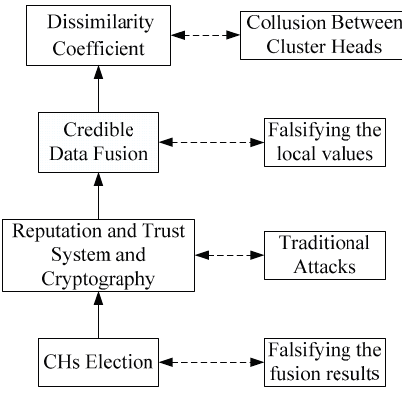
Figure 2. A brief mechanism to defend against